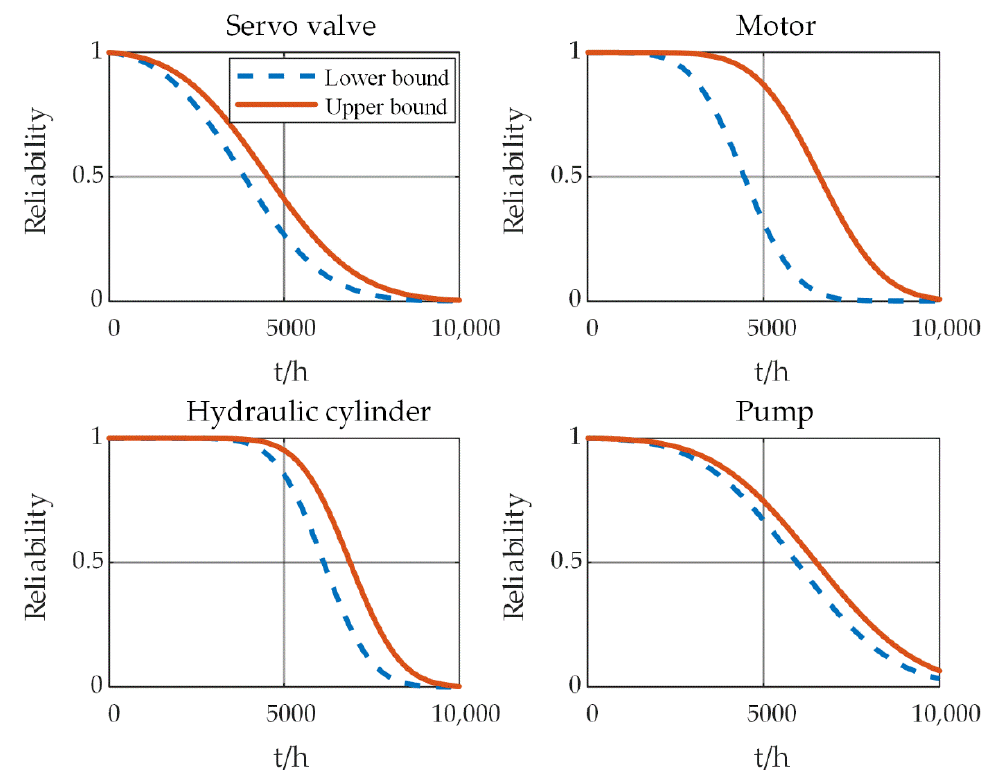
Figure 6. Component reliability considering the upper and lower bounds of failure threshold.